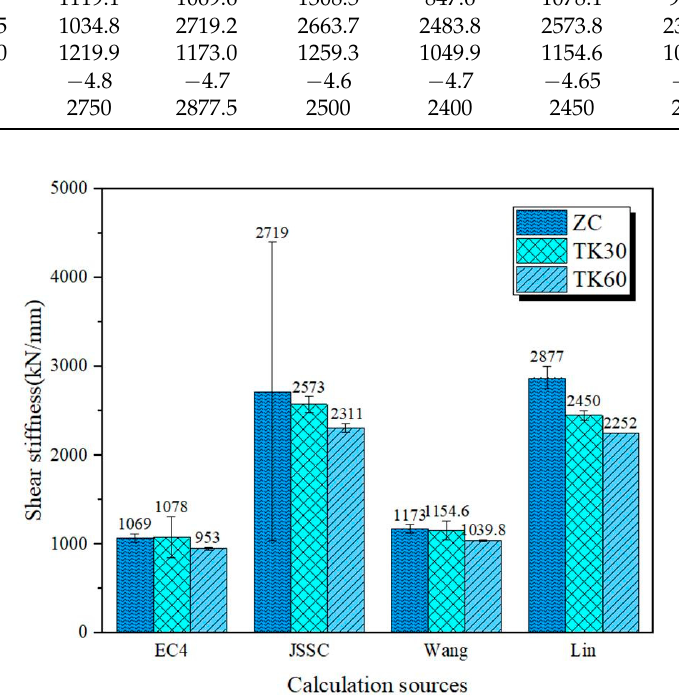
Figure 15. Comparison of shear stiffness from different calculation sources.